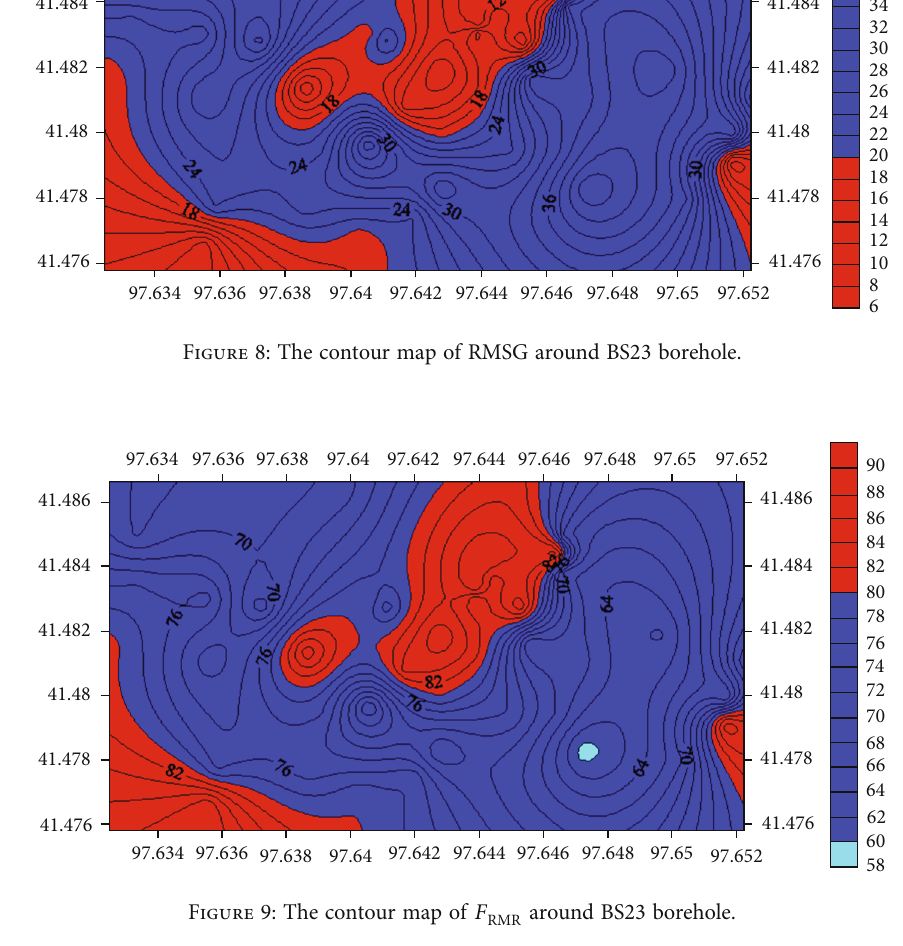
RMR around BS23 borehole.